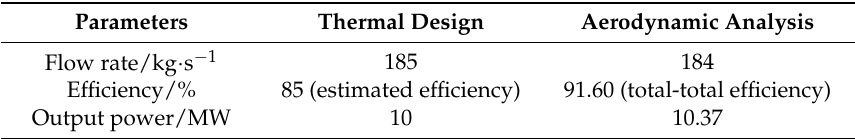
Table 5. Performance parameters.